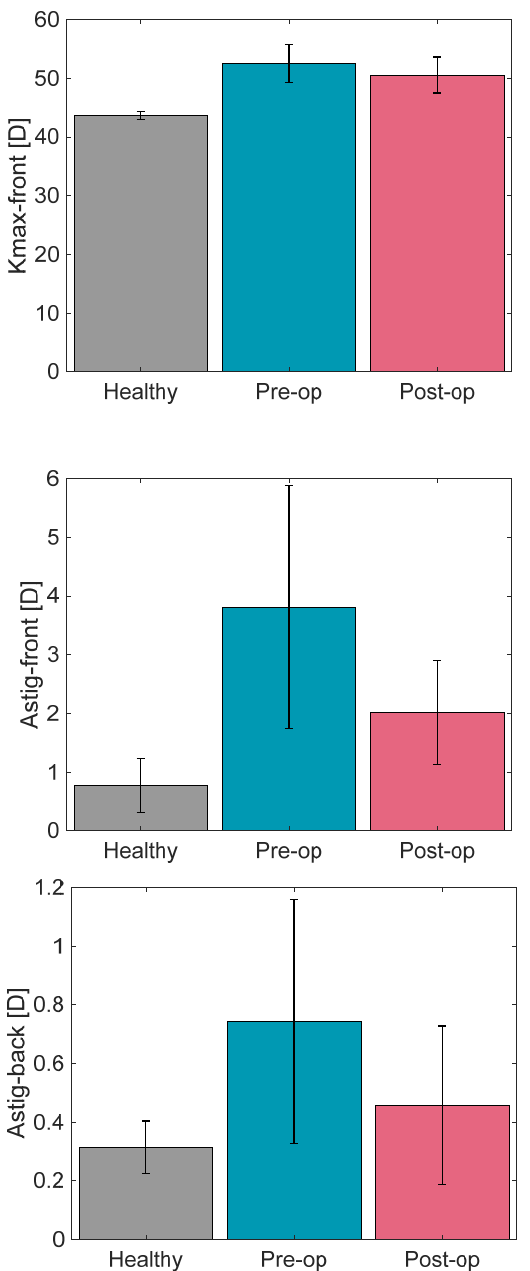
Figure 4. Kmax-front, Astig-front and Astig-back based on Pentacam-derived topometric data for the Figure 4. Kmax ‐ front, Astig ‐ front and Astig ‐ back based on Pentacam ‐ derived topometric data for healthy group, and the pre- and post-operation state of the KCN the healthy group, and the pre ‐ and post ‐ operation state of the KCN patients.